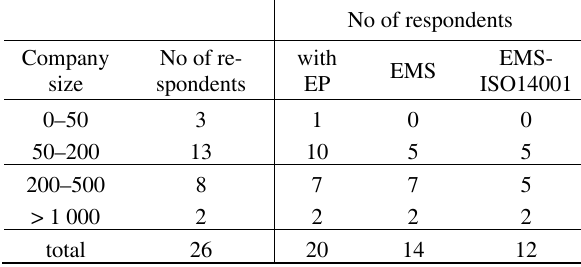
Table 6. Number of respondents with environmental policy (EP), EMS and ISO 14001-compliant EMS with re-